Question: Express in one sentence what the figure is showing.
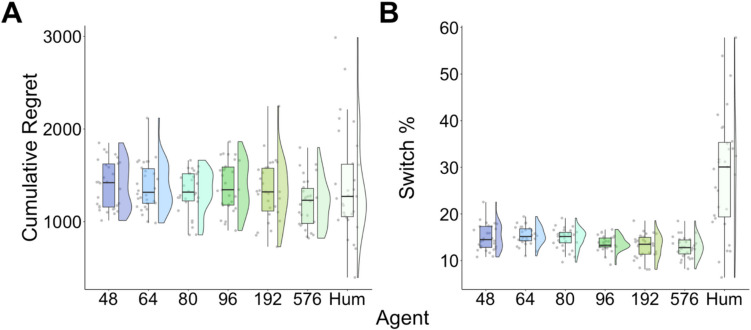
Answer: Model-agnostic results. X-axes represent networks grouped by capacity, defined by the no. of hidden units (48–576), along with human learners (Hum). ( A ) Overall performance measured by cumulative regret. ( B ) Switch rate. For each network instance, values were averaged across runs